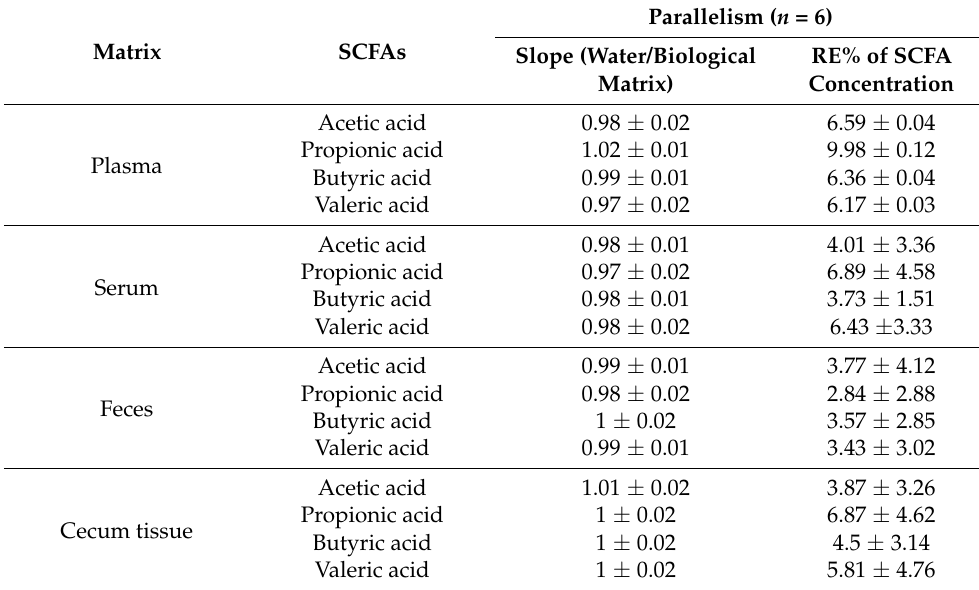
Table 3. Parallelism results including slope comparison and relative error (RE) of SCFA concentration obtained from the curve in the biological matrix and water. Presented values are mean ± standard deviation.